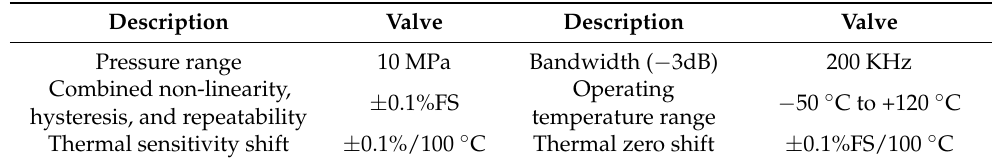
Table 1. Parameters of HM90(10 MPa)-H3-3-V2-F2.